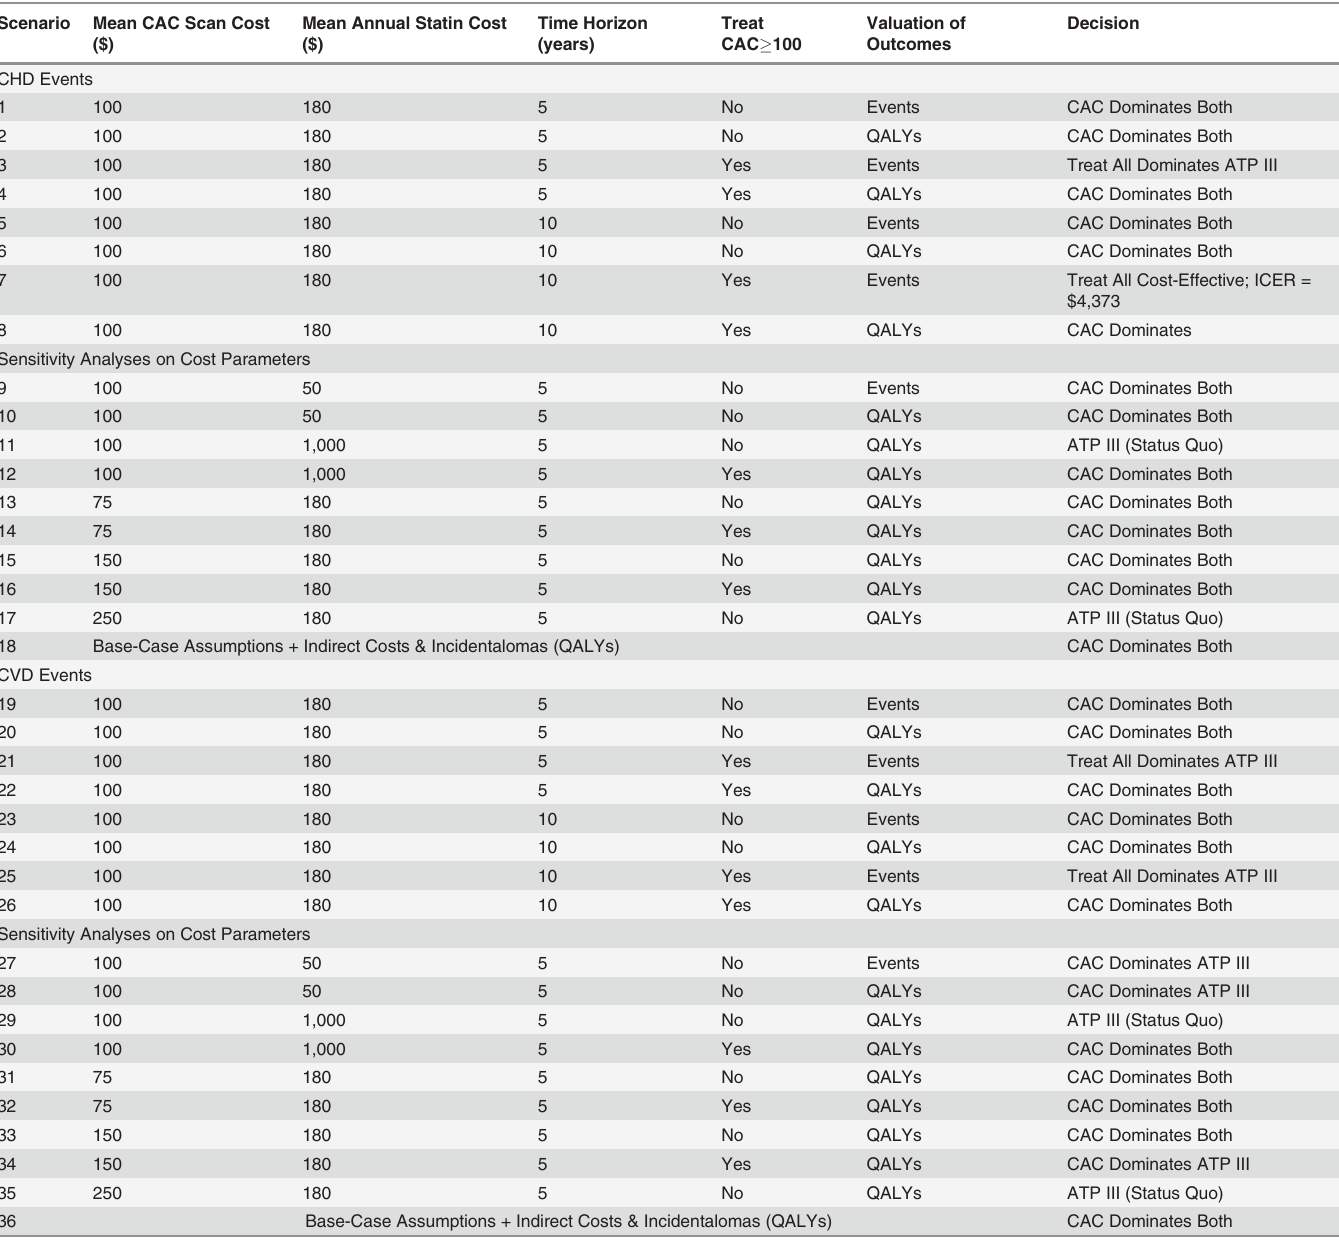
Table 4. Results Using Base-Case MESA Event